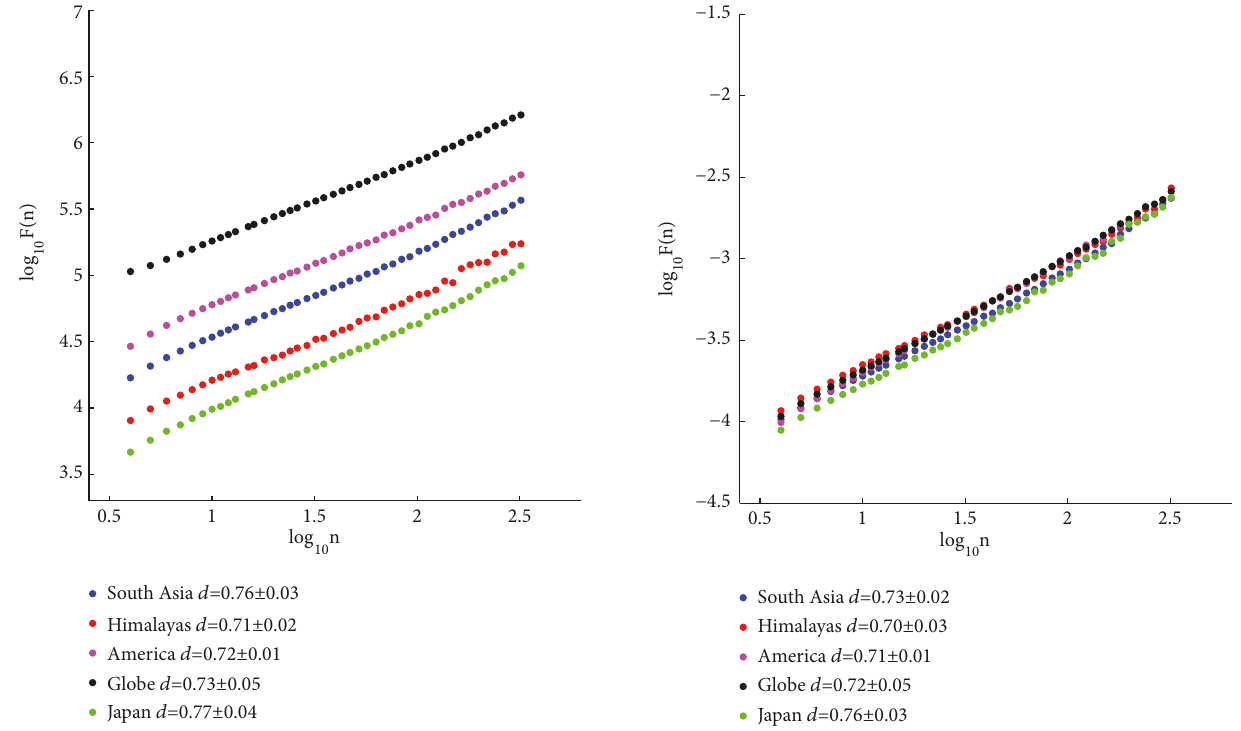
Figure 3: log 10 𝐹(𝑛) -log 10 𝑛 plots for the time series of hypocenter separation distance in catalogs: South Asia, Himalayas, America, Globe, and Japan. The employed method for calculations is the modified DFA.